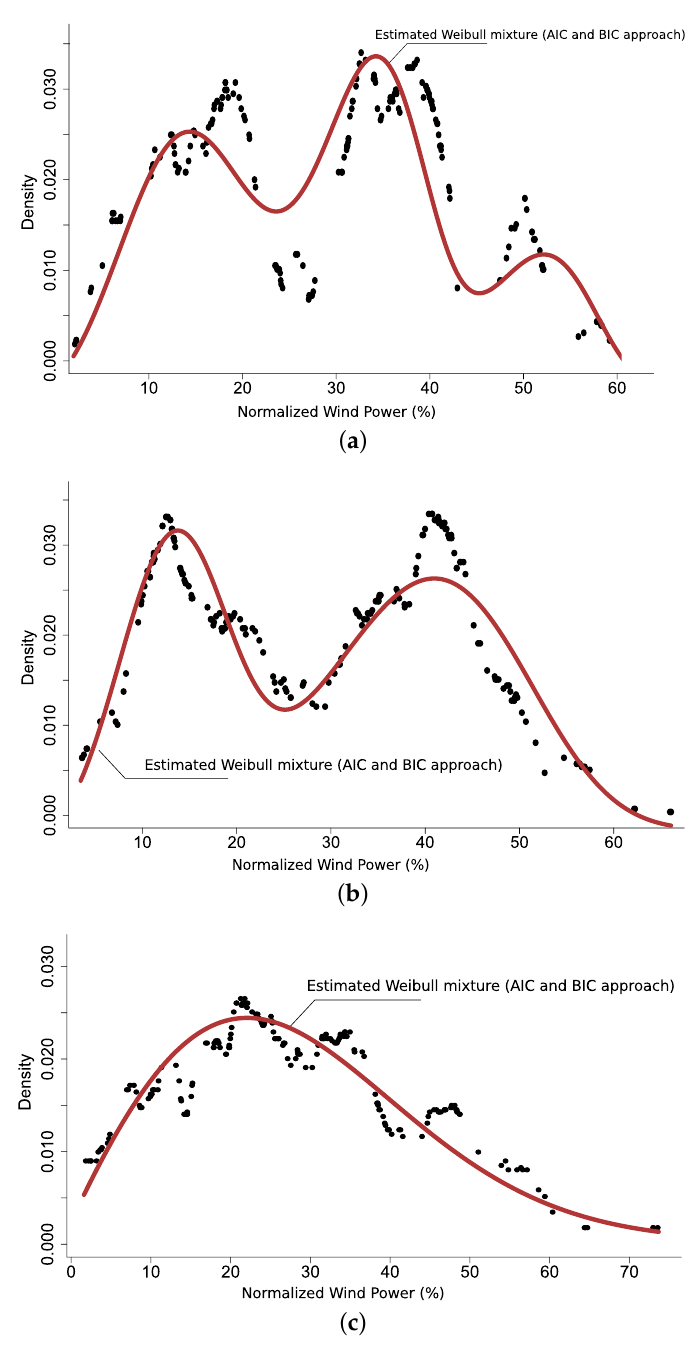
Figure 4. Empirical density functions and fitted Weibull mixture models of aggregated wind power generation from the observed data at three selected hours of the day for year 2010 and Q4. AIC and BIC approaches lead to the same solution. ( a ) Year 2010, Q4, hour 03. The fitted distribution is a mixture of three Weibull densities with weights and scale and shape parameters (0.44, 0.37, 0.19), (35.22, 17.47, 52.19), and (6.86, 2.95, 9.73), respectively; ( b ) year 2010, Q4, hour 06. The fitted distribution is a mixture of two Weibull densities with weights and scale and shape parameters (0.63, 0.37), (41.73, 15.54) and (4.55, 3.18), respectively; and ( c ) year 2010, Q4, hour 13. The fitted distribution is a mixture of one Weibull density with scale and shape parameters 33.86 and 1.95,